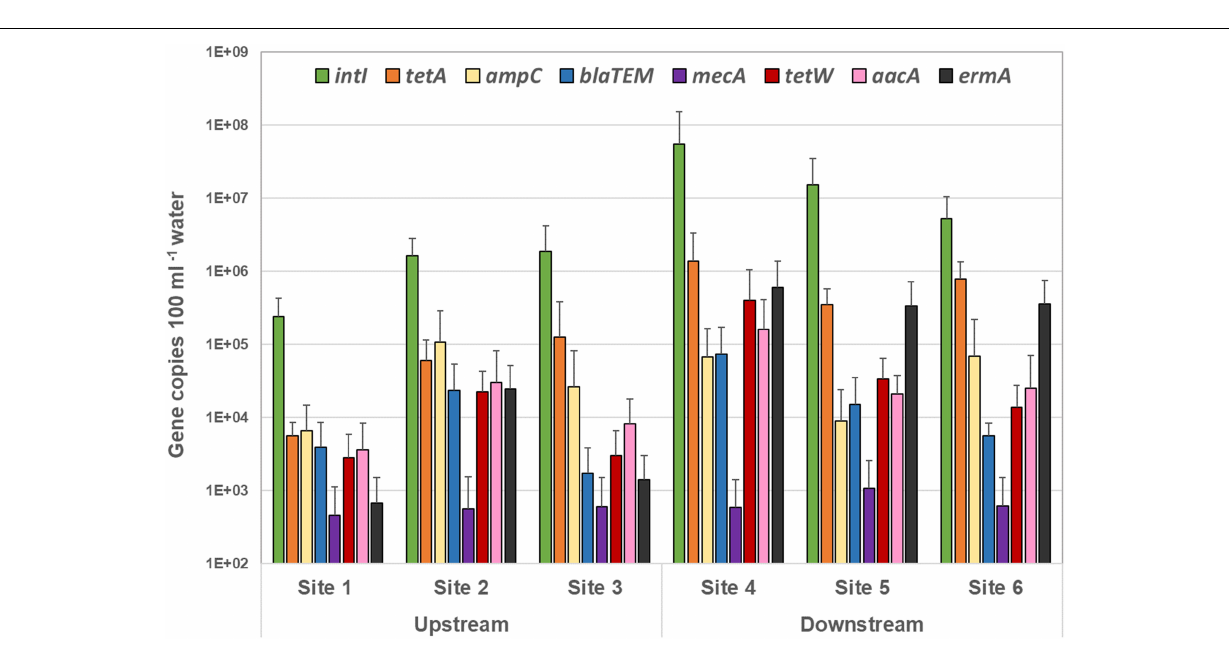
FIGURE 5 | Quantity of each antibiotic resistance gene over all sampling events detected by quantitative PCR in the upstream sites and downstream sites. The target gene values (gene copies 100 ml − 1 sample) are displayed in mean of all sampling events, and the standard deviations represent the variation among the six sampling